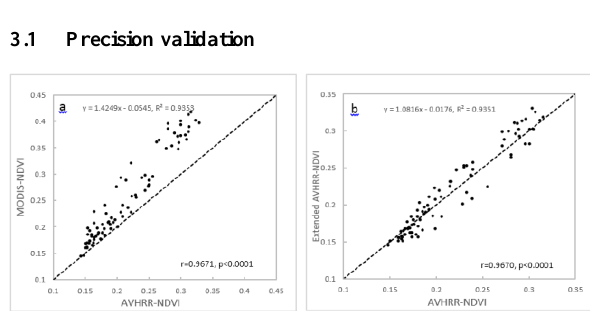
Figure 3. Results of precision validation by spatial mean data: (a) original data; (b) extended